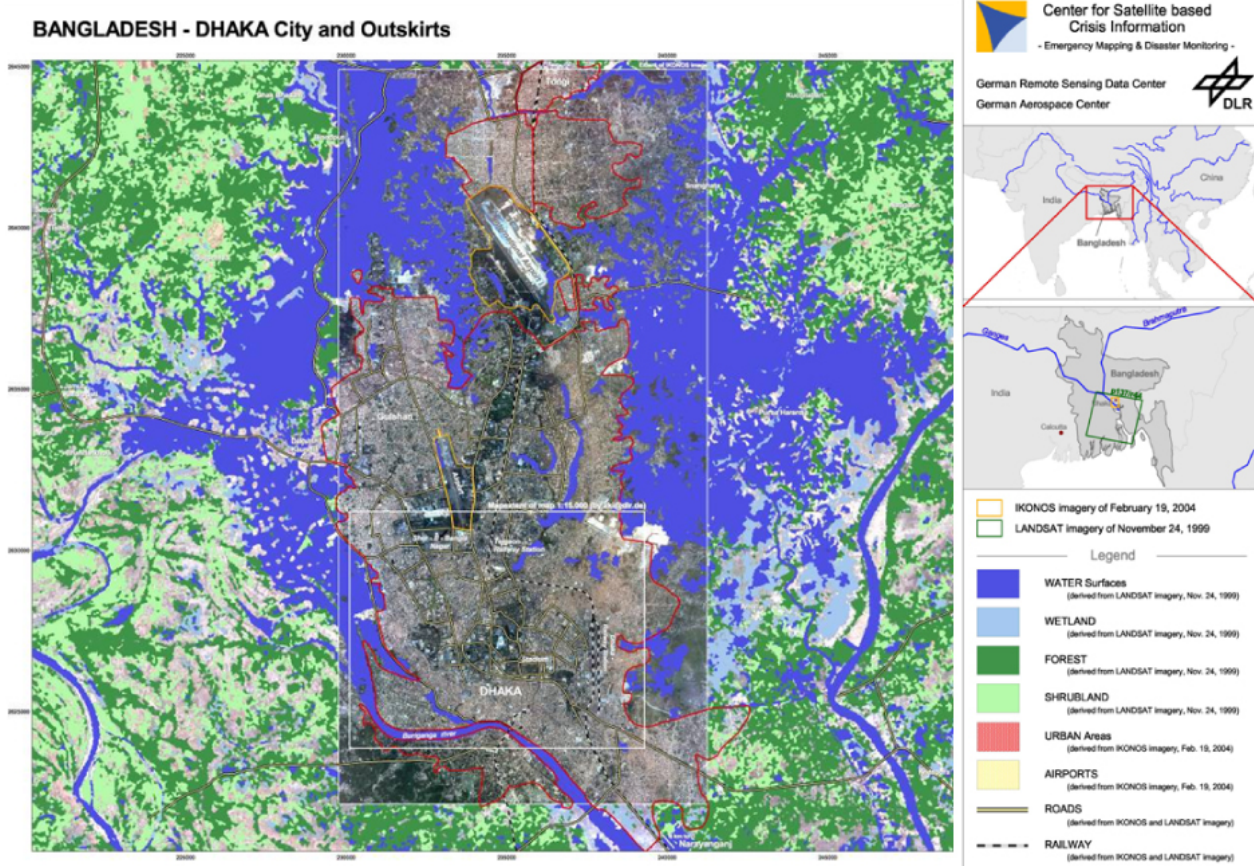
Fig. 8. Flooding of the megacity of Dhaka: rapid mapping result produced at DLR-ZKI to derive up-to-date spatial information for relief operations